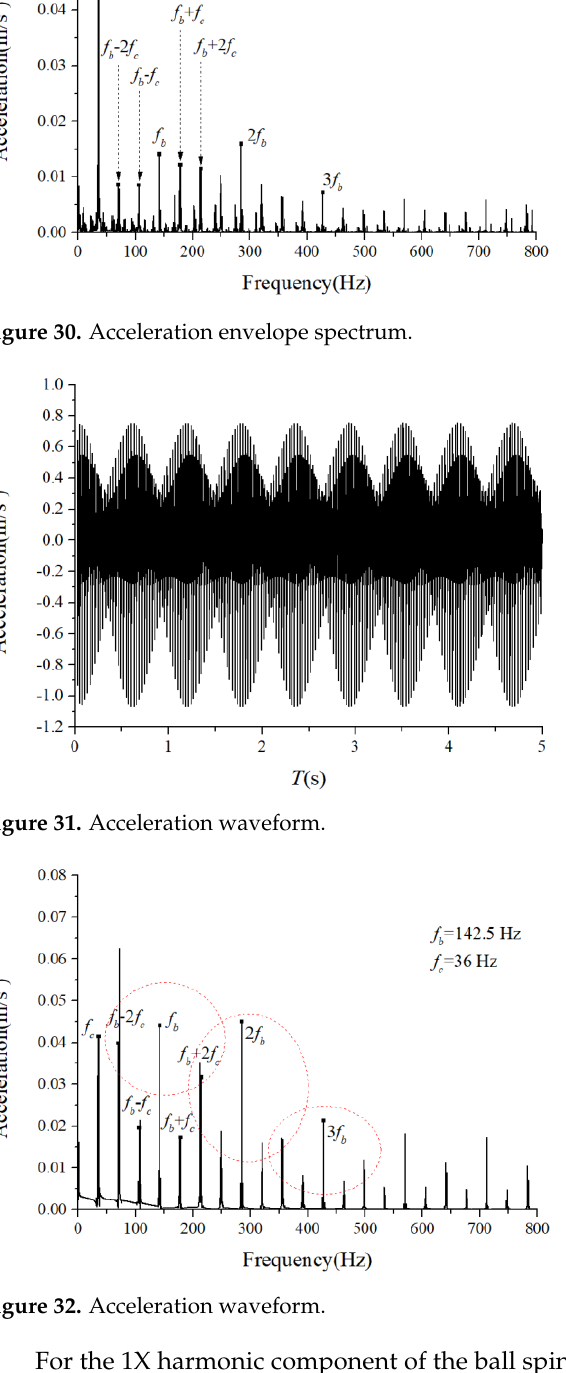
Figure 32. Acceleration waveform.